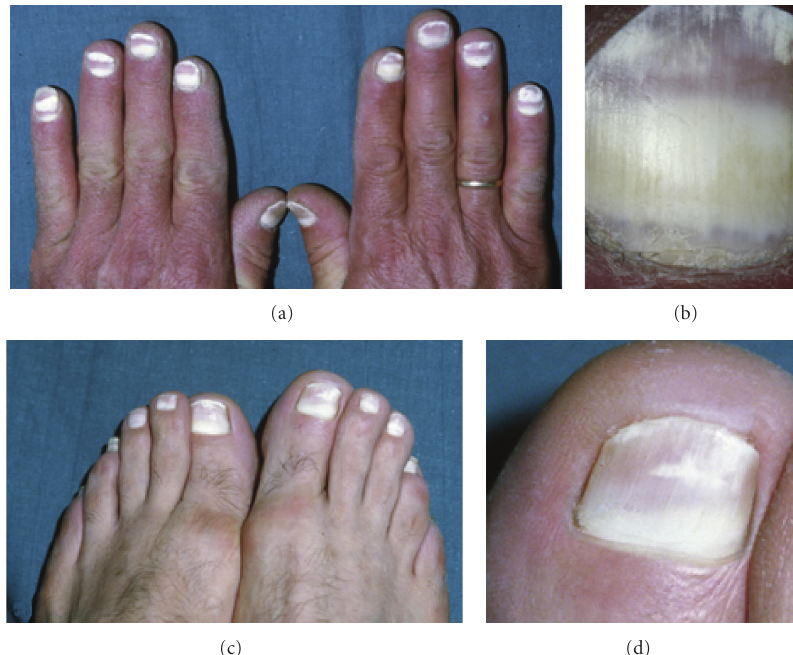
Figure 1: (a)-(b) Both hands had opaque nail plates characteristic of leukonychia totalis. (c)-(d) The patient toenails exhibited leukonychia totalis and partialis.